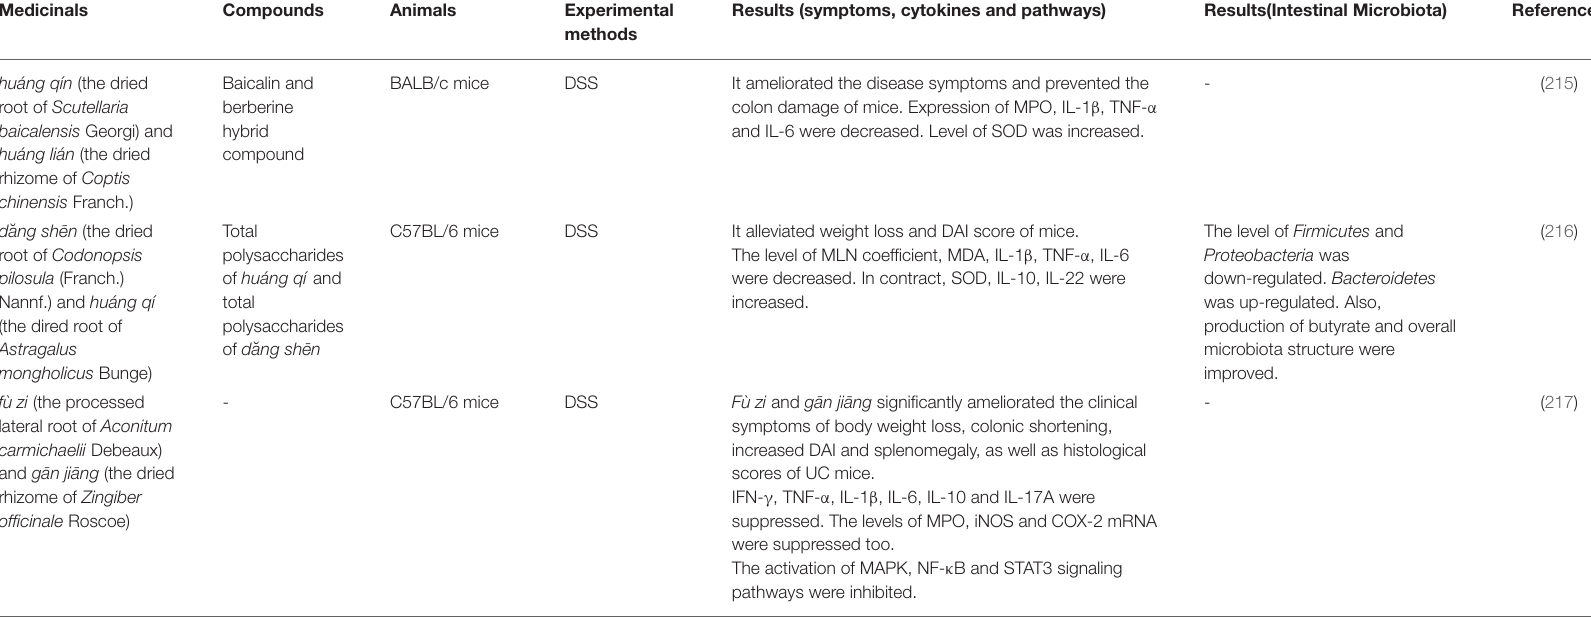
TABLE 6 | Application of couplet medicinals in animal models of